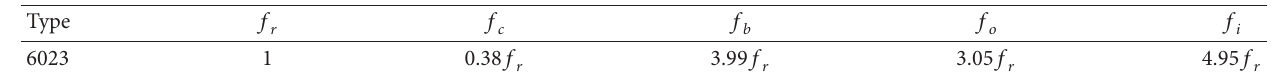
Table 3: Characteristic frequencies of test bearing